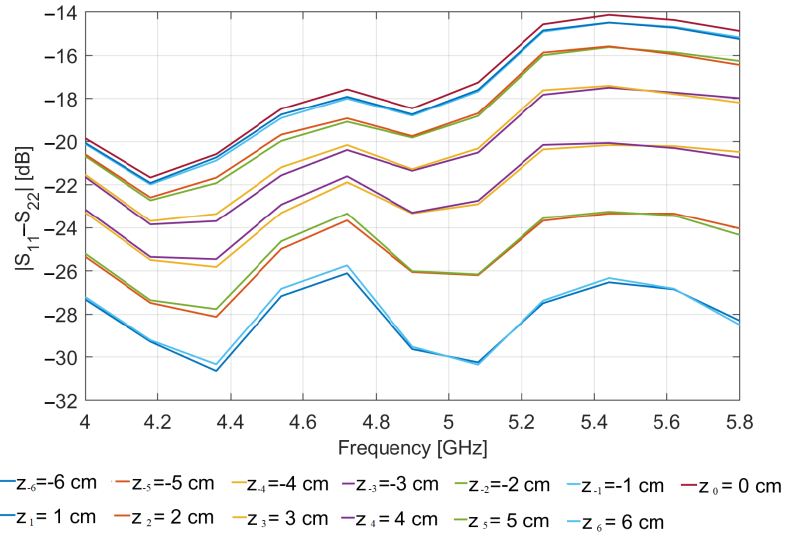
Figure 10. |S 11 − S 22 | (in dB) vs. frequency simulated when the OUT is displaced of +5 mm along the y -axis.